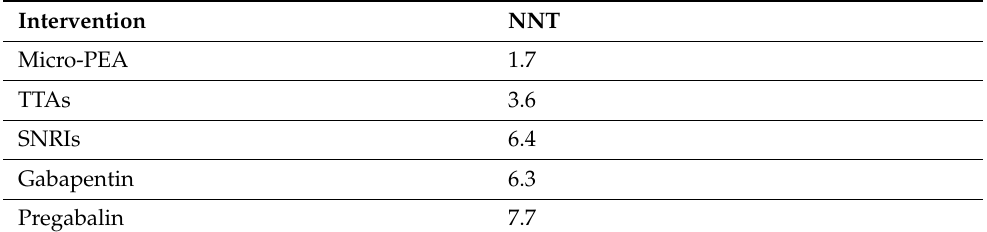
Table 8. NNTs for micro-PEA and the main first-line treatments for neuropathic pain (i.e., the number of patients to treat in order to obtain one patient with at least 50% pain relief) [216,263]. Intervention NNT Micro-PEA 1.7 TTAs 3.6 SNRIs 6.4 Gabapentin 6.3 Pregabalin